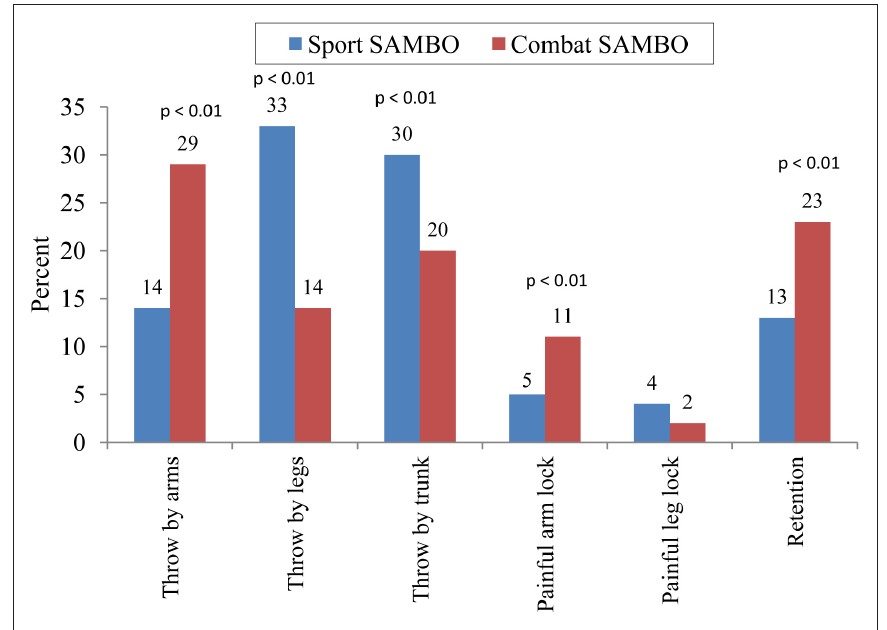
Figure. Distribution of the indicators of actions